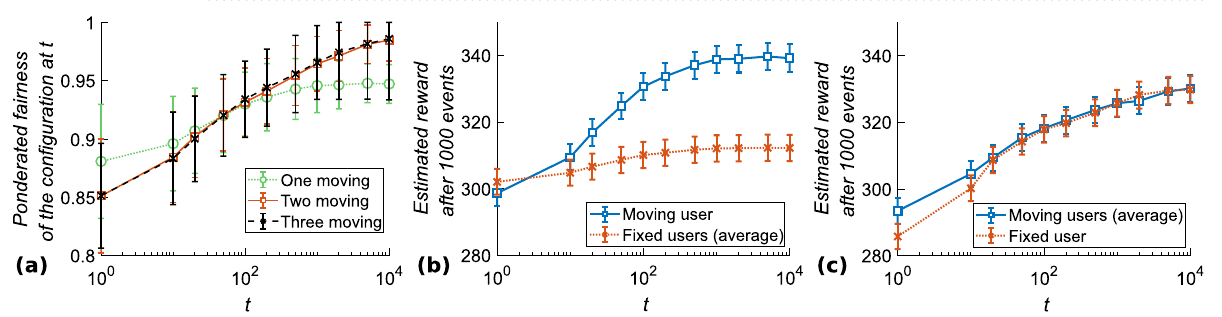
Figure 4. ( a ) Total reward, ( b ) fairness, and ( c ) pondered fairness I p for N measurement bases independently. Red circles in ( c ) indicate optimal angle combinations from which all other can be deduced by global rotation or a period of π .